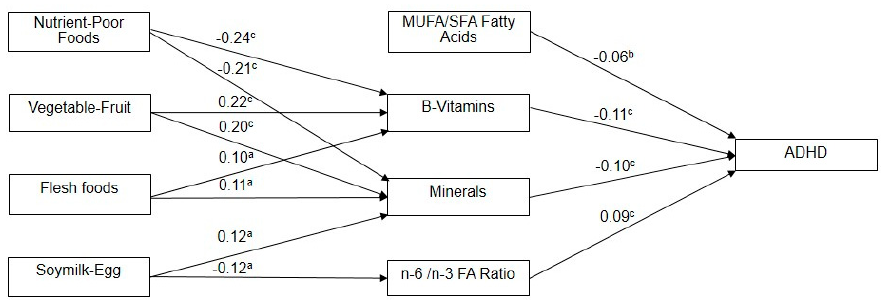
Figure 1. Model for demonstrating the path analysis from diet factors, nutrition factors to a diagnosis of ADHD. MUFA: monounsaturated fatty acids; SFA: saturated fatty acids; a p < 0.05, b p < 0.01,